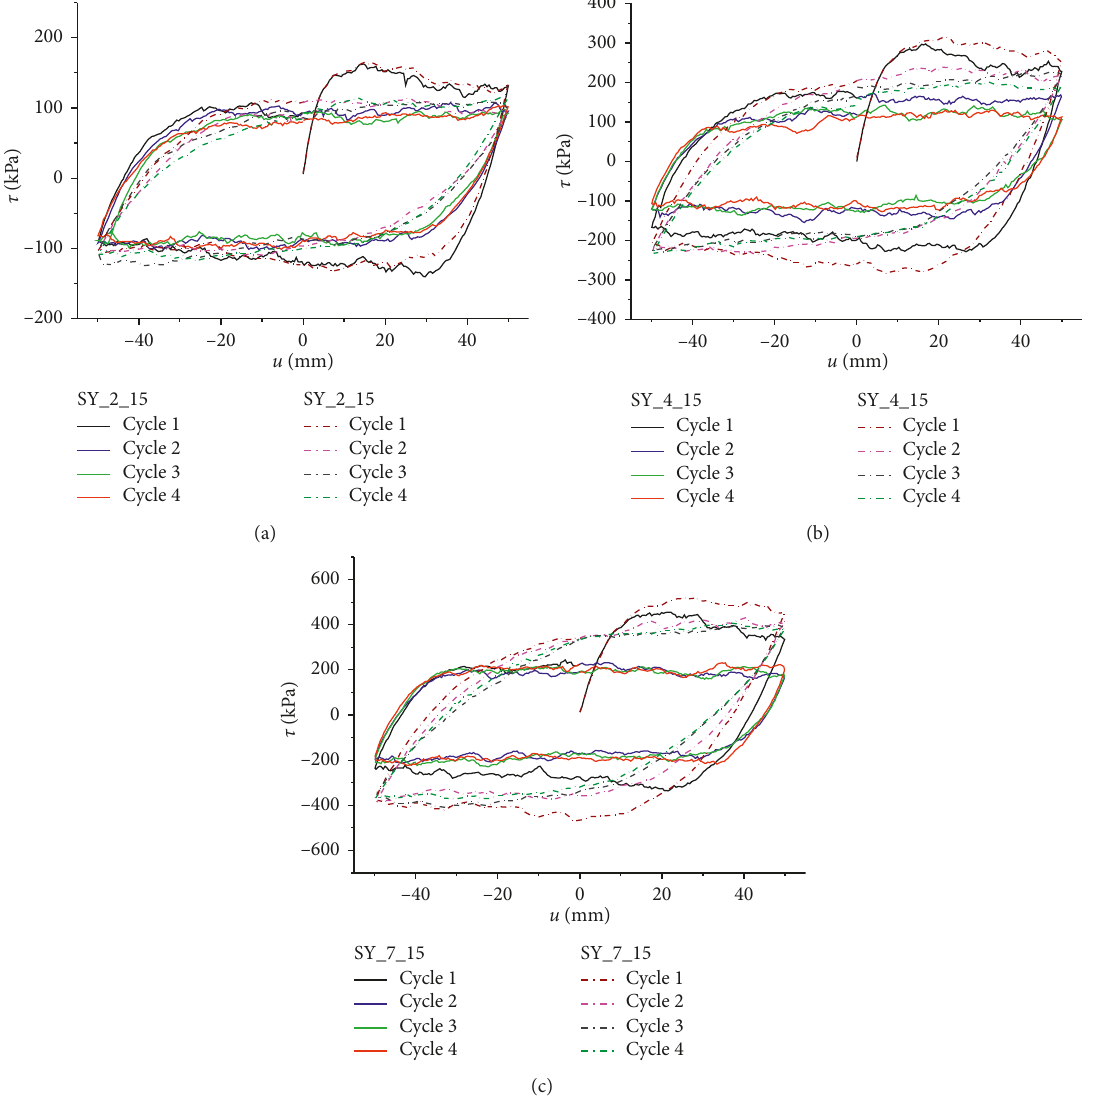
Figure 9: Comparison between the reference group and unbreakable group of DEM simulation results in terms of shear displacement against shear stress under constant normal stress: (a) 200kPa; (b) 400kPa; (c)